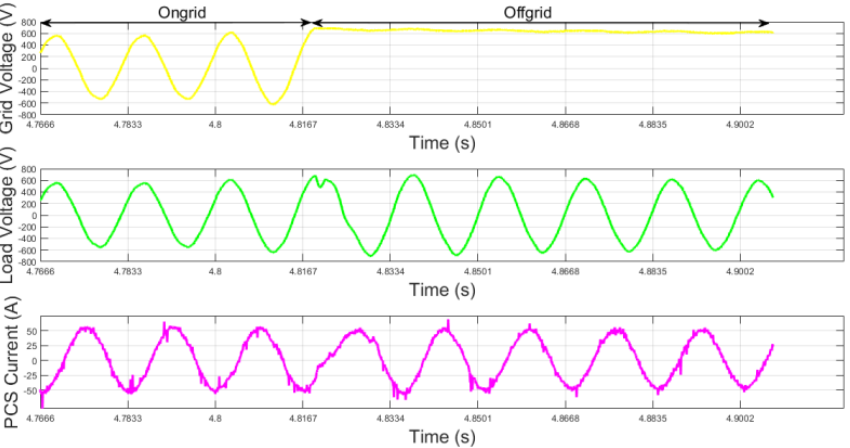
Figure 9. Stage 4: Backup on capacitive loads—signal captured by the oscilloscope at the time the backup was simulated.